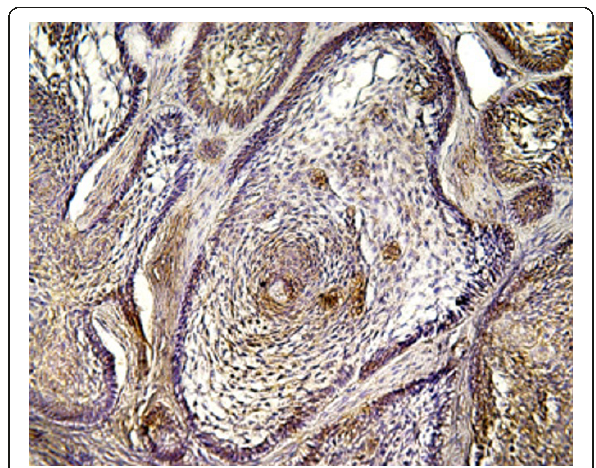
Figure 8 Photomicrograph of follicular variant of MCA showing cytoplasmic immunopositivity of both ameloblast like cells & stellate reticulum like cells. Note the immunonegativity of most of the ameloblast like cells lining the large-sized follicles and peritumoral reaction (AntiOPN. Original magnification x40)